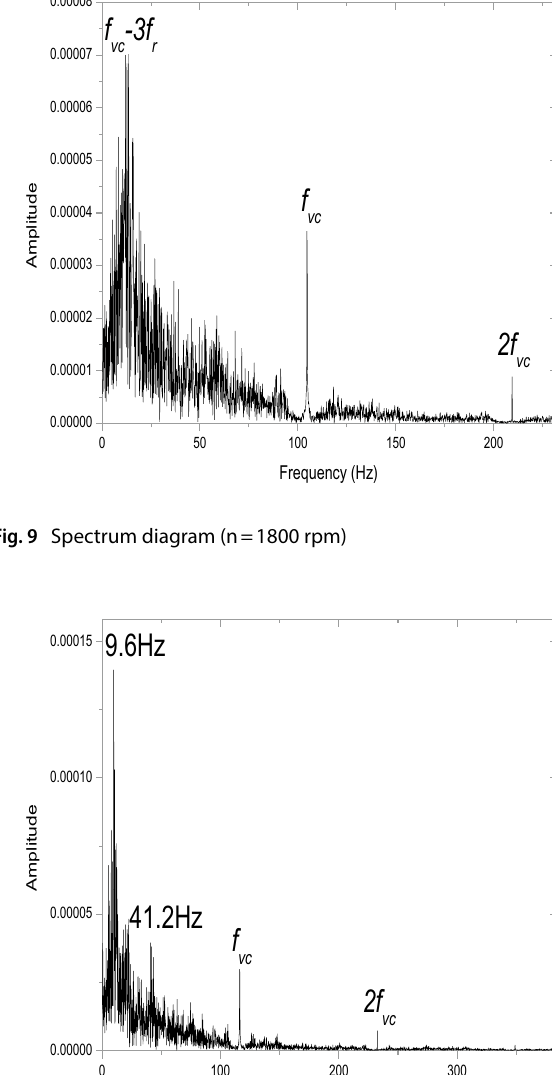
Fig. 12 Bifurcation diagram of the dynamic response Y vs. eccen- tricity of the rotor ee; S means the relatively stable region; U means the relatively unstable